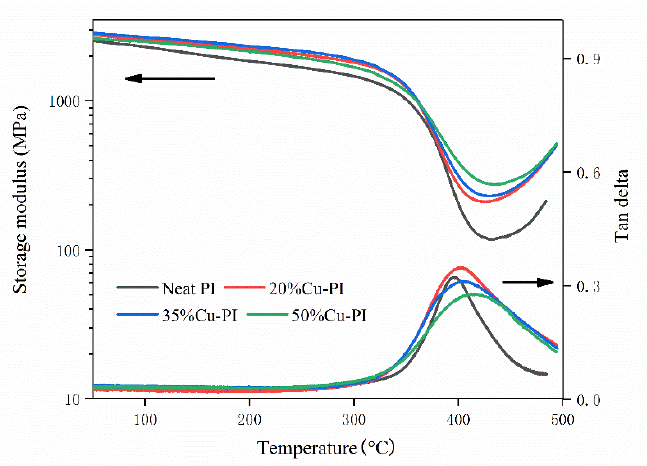
Figure 5. DMA curves of neat PI and Cu-PI films.